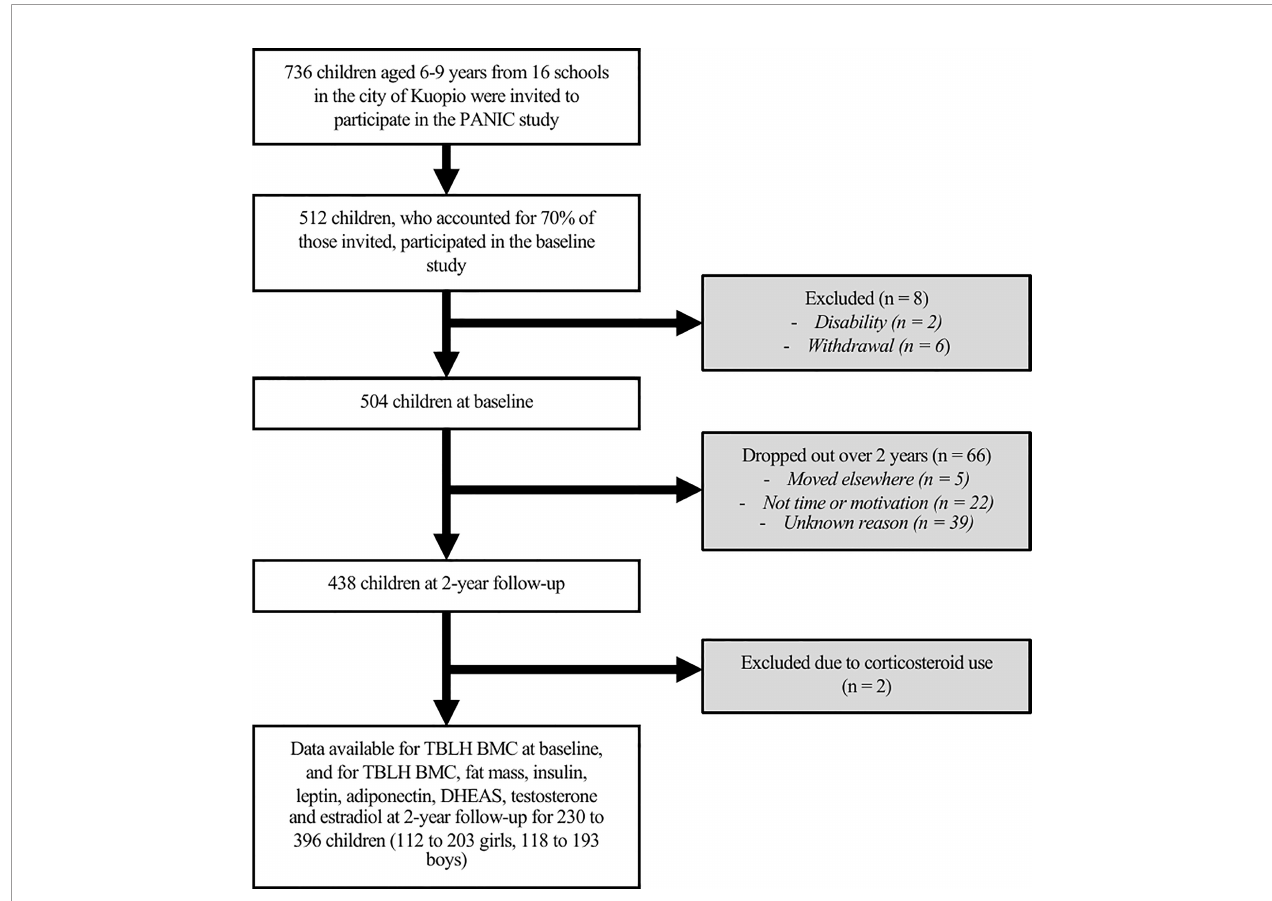
FIGURE 1 | Participant fl